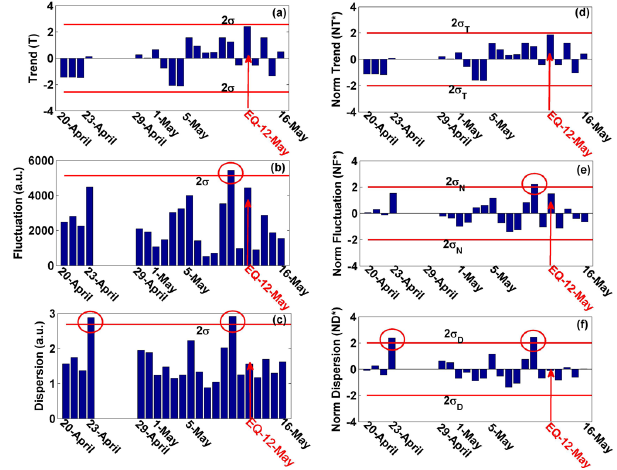
Fig. 4. Nighttime fluctuation analysis for (a) trend, (b) fluctuation, (c) dispersion (d) norm-trend, (e) norm-fluctuation and (f) norm- dispersion. The horizontal line in each panel shows 2 σ criteria to define the anomalous